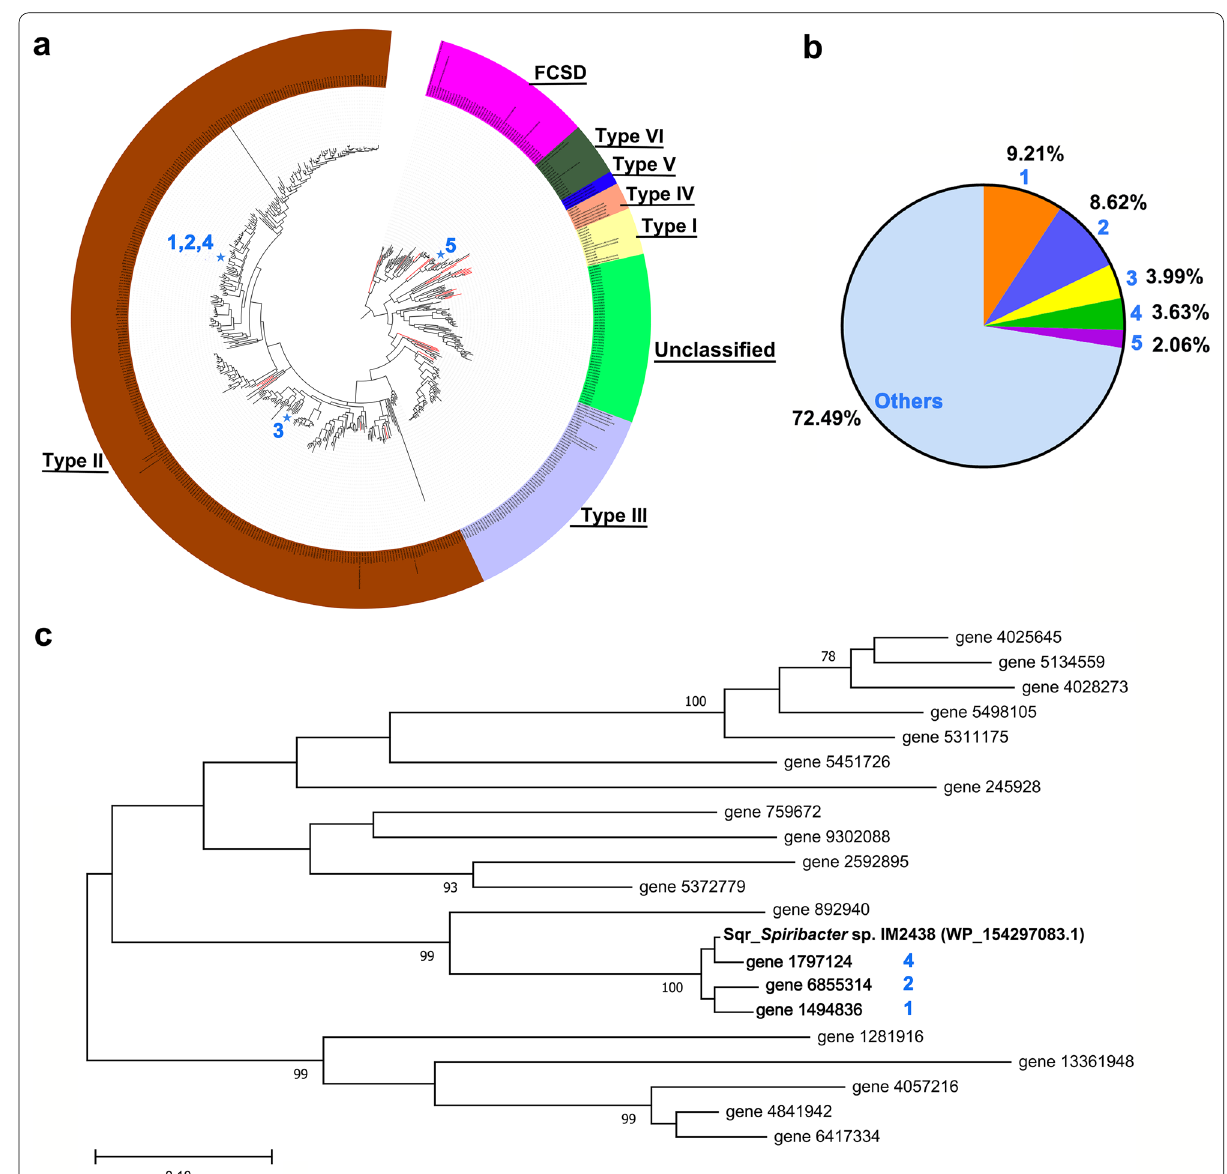
Fig. 1 Bioinformatic analysis of sulfide oxidation genes from microbial metagenomes of soda-saline lakes. a Phylogenetic analysis of sulfide: quinone oxidoreductase (Sqr) and flavocytochrome c: sulfide dehydrogenase (FCSD). The sequences were obtained from previous research (Zhao et al. 2020). The evolutionary tree was inferred by using the Maximum Likelihood method and JTT matrix-based model (Jones et al. 1992). The tree with the highest log likelihood (-644966.85) is shown. Initial trees for the heuristic search were automatically obtained by applying Neighbor-Join and BioNJ algorithms to a matrix of pairwise distances estimated using the JTT model. Then, the topology with a superior log-likelihood value was selected. There were 986 positions in the final dataset. This analysis involved 484 sulfide oxidases and 33 reference sequences indicated by red branches (All sequence data shown in Additional file 1: Table S1). The outer circle was colored by different Sqr types and FCSD. The positions of the top five Sqrs in abundance were marked with blue five-pointed stars. The blue numbers (1 to 5) were the abundance rankings corresponding to those in Fig. 1b and c. b The percentage of the total abundance of the proteins in 18 samples. The abundance data were described in previous work (Zhao et al. 2020) and were shown in Additional file 1: Table S2. c Maximum Likelihood phylogenetic tree based on the Sqr of Spiribacter sp. IM2438 and the partial type II Sqrs in Fig. 1a (20 protein sequence names shown in red in Additional file 1: Table S1). Bootstrap values (%) were based on 1000 replicates and depicted with more than 70 % bootstrap support. NCBI reference accession numbers are shown in parentheses. Bar, 0.01 substitutions per nucleotide